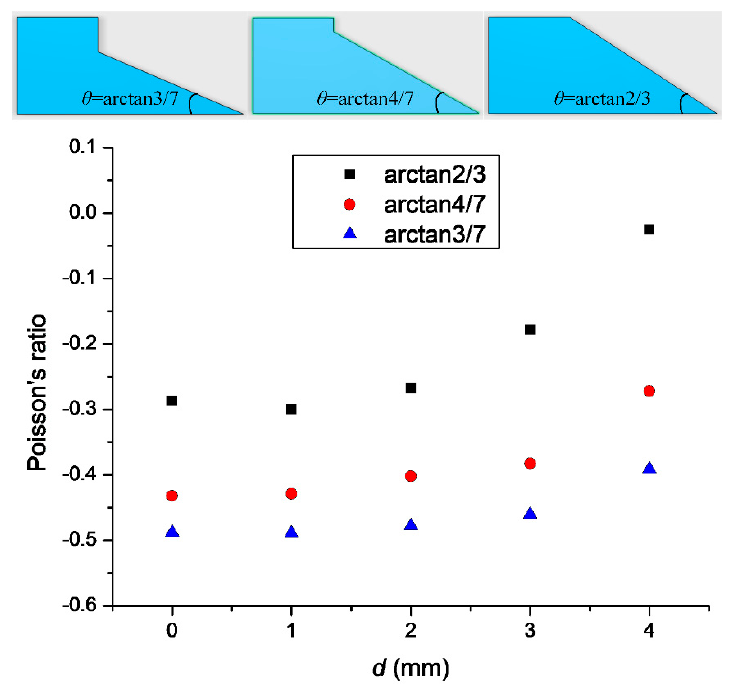
Figure 6. The relationship between θ and Poisson’s ratio.